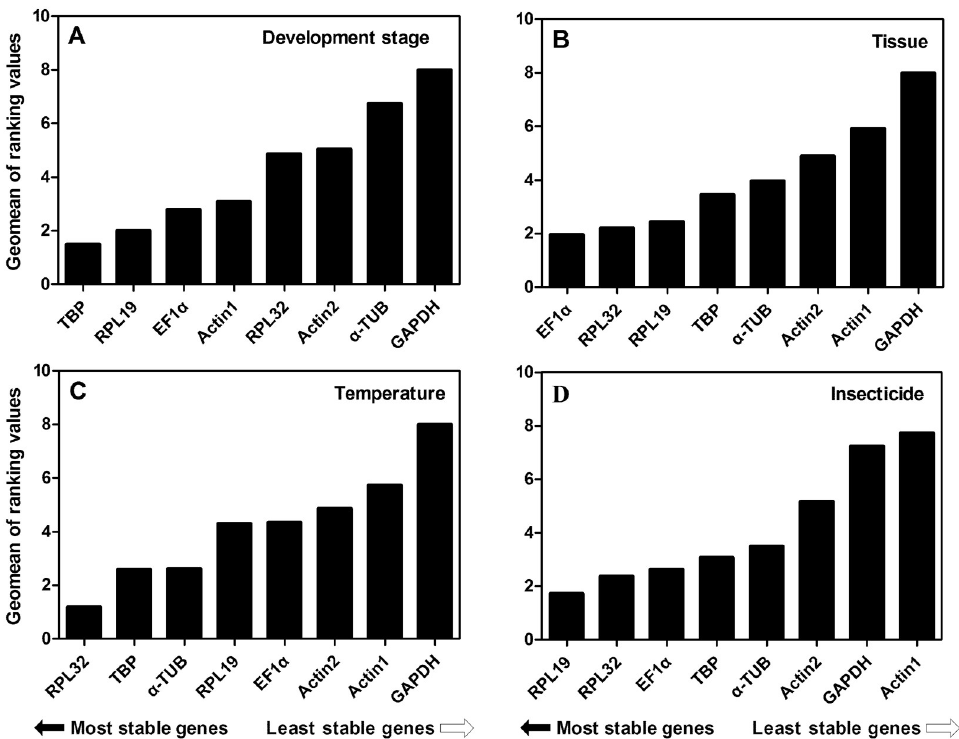
Fig 2. The stability of candidate reference gene expression under different conditions based on RefFinder. The expression stabilities of candidate reference genes were evaluated in diverse conditions including developmental stage (A), tissue (B), temperature stress (C), and insecticide exposure (D).